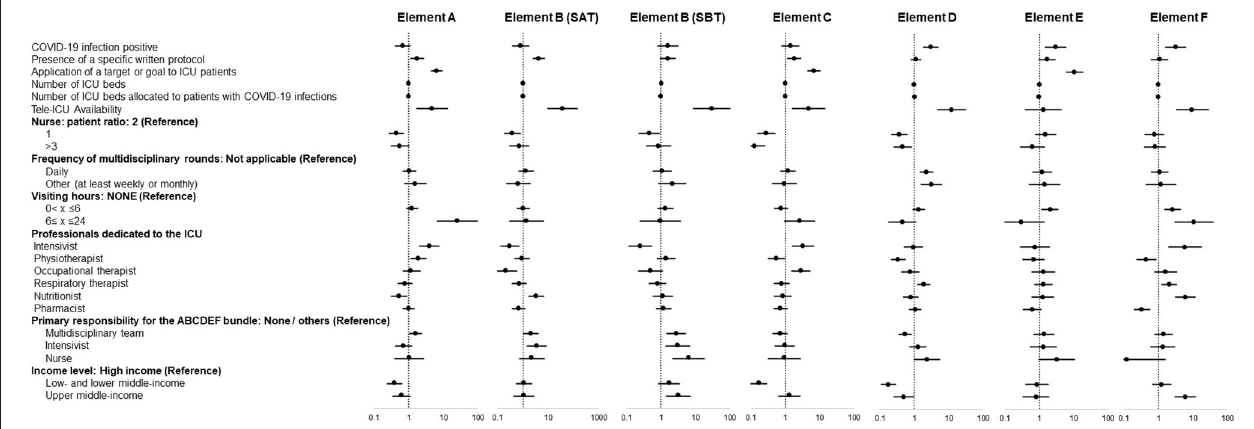
FIGURE 3 | Independent factors associated with implementation of each element of the ABCDEF bundle. Data in figure are shown as adjusted odds ratio with 95% confidential interval.